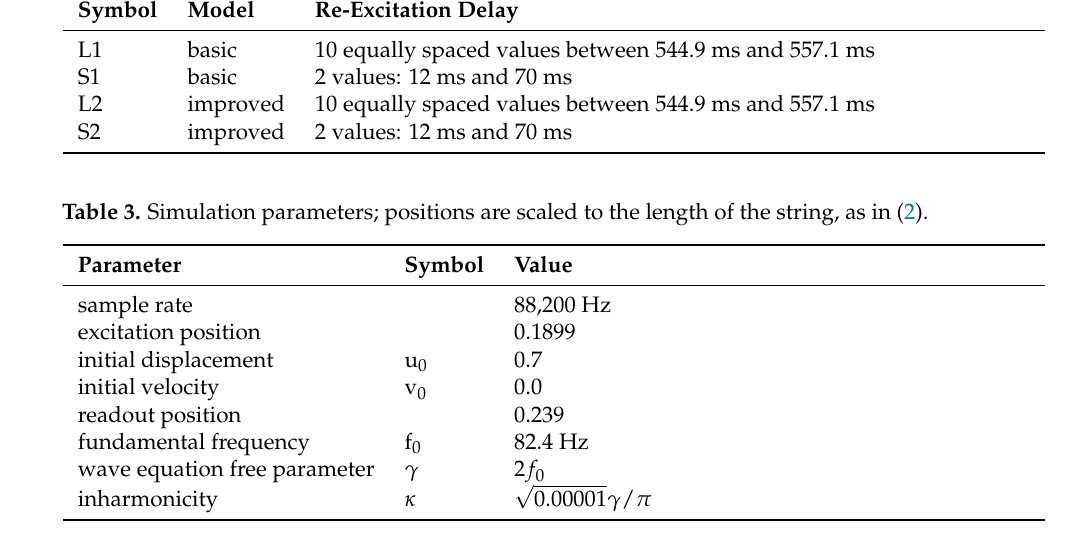
Table 2. Description of simulations variants with symbols representing them for brevity in the following sections.